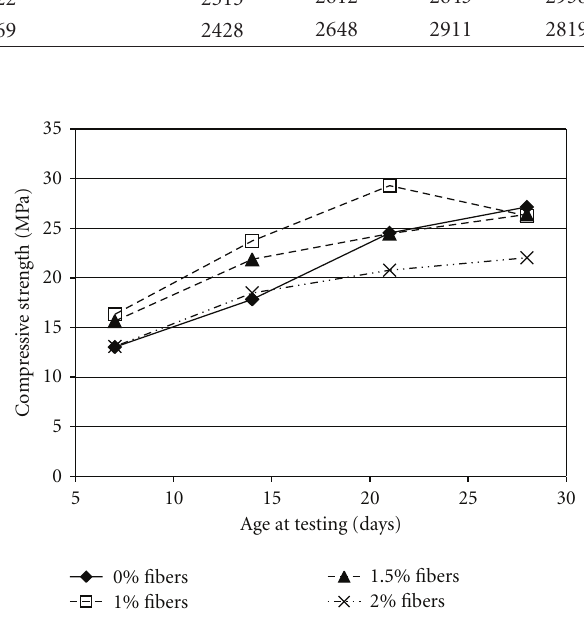
Figure 6: E ff ect of increasing percentages of recycled polymer fiber on the compressive strength of a mortar with ten percent type I/II cement. Table 6: Modulus of elasticity for di ff erent percentages of fibers for a mortar made with 10% type I/II cement